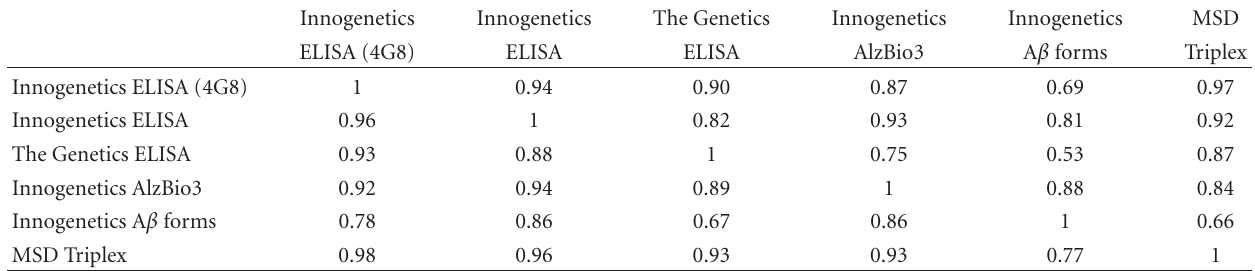
Table 2: Correlation matrix for the evaluated A β assays. The correlation between the levels of A β 42 in di ff erent assays. The correlation coe ffi cients for the neat and diluted CSF samples are shown in the upper right and lower left part,